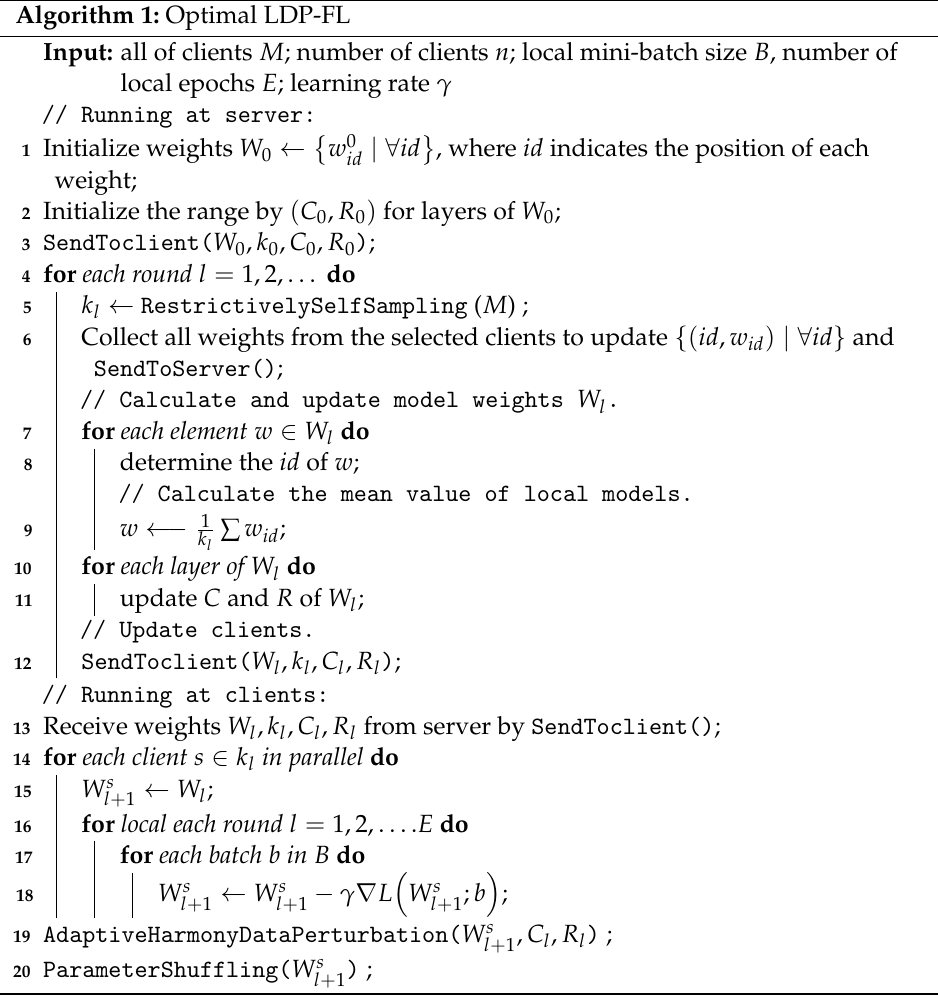
Algorithm 1: Optimal